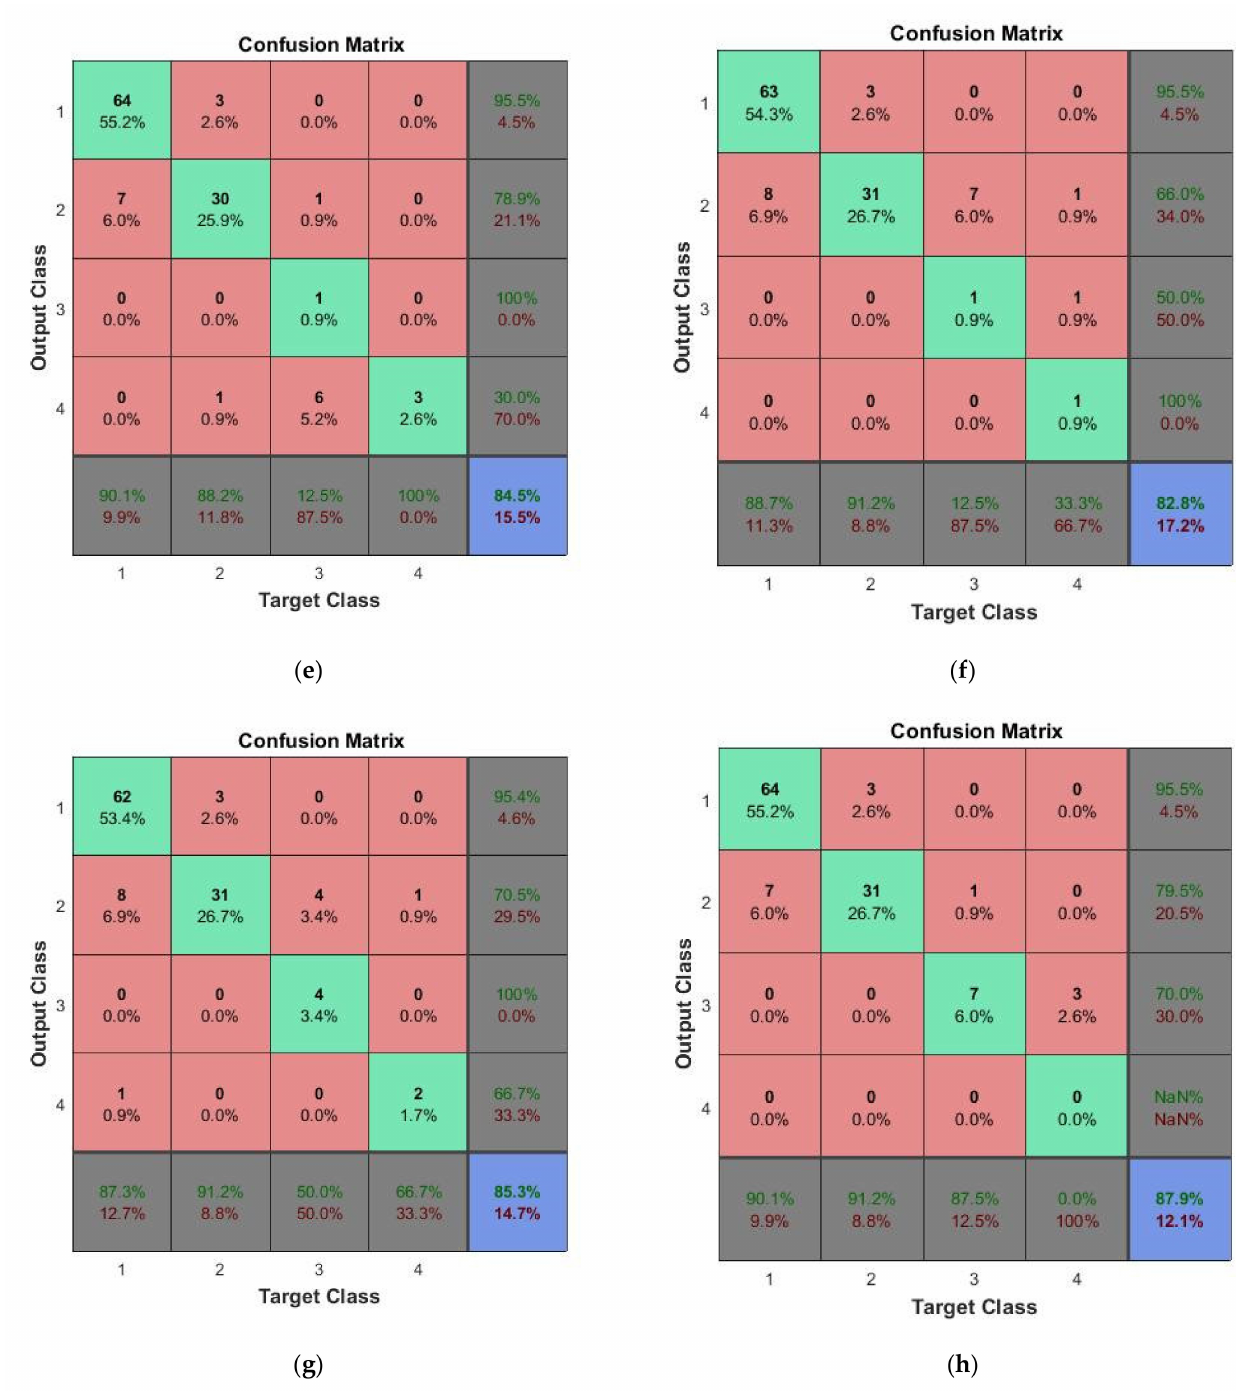
Figure 7. This figure represents the confusion matrix for the second experiment using ( a ) only linear SVM, ( b ) only kernel SVM, ( c ) only PCA feature extraction and linear SVM, ( d ) only PCA feature extraction and kernel SVM, ( e ) only LDA feature extraction and linear SVM, ( f ) only LDA feature extraction and kernel SVM, ( g ) hybrid feature extraction and linear SVM, and ( h ) hybrid feature extraction and kernel